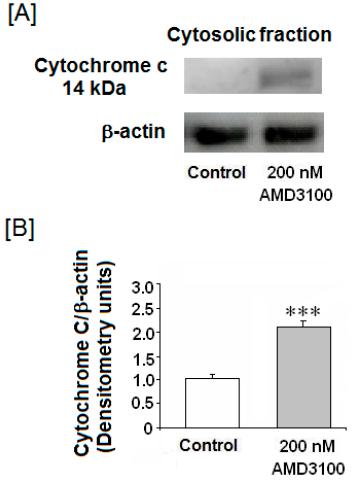
Figure 4. Effect of AMD3100 on cytochrome c release to the cytosol. ( A ) Cytochrome c levels were measured by Western blot; ( B ) average of densitometry from three membranes of three different Western blot analyses. Results are means ± SEM from the three membranes densitometry. The statistical significance was evaluated by t- Student test using Sigma Plot 11 software. Differences were considered significant at p < 0.05. The asterisks indicates statistical significance as compared to control, *** p < 0.001.